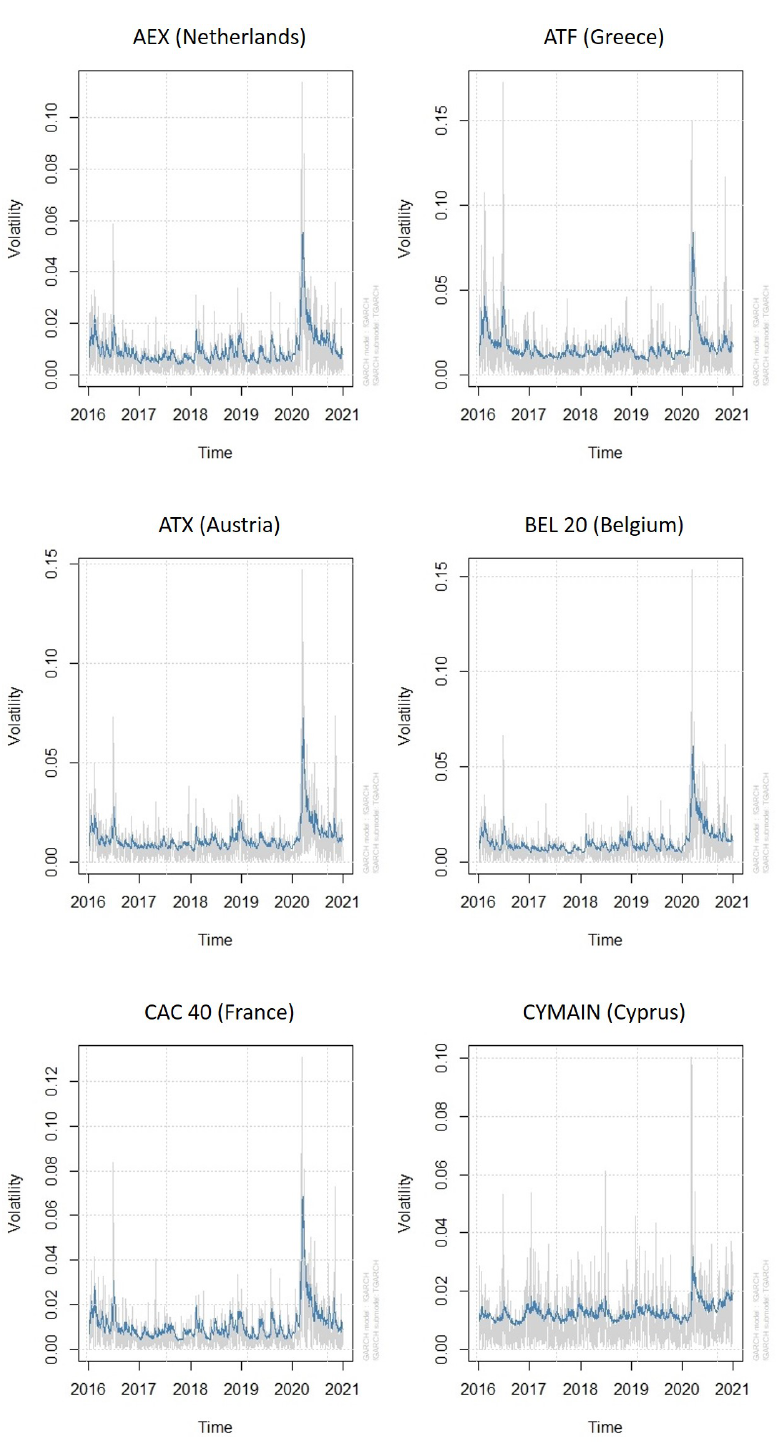
Figure A1. Estimated conditional standard deviation (volatility) versus absolute daily returns